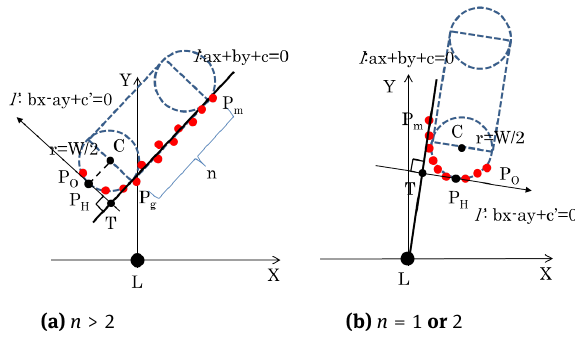
Fig. 12. Calculation of Position and Direction of Foot in not "Fuzzy"